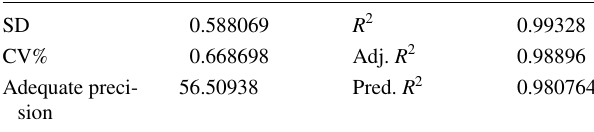
Table 8 Model coefficient for Pb(II) ion removal using OSA